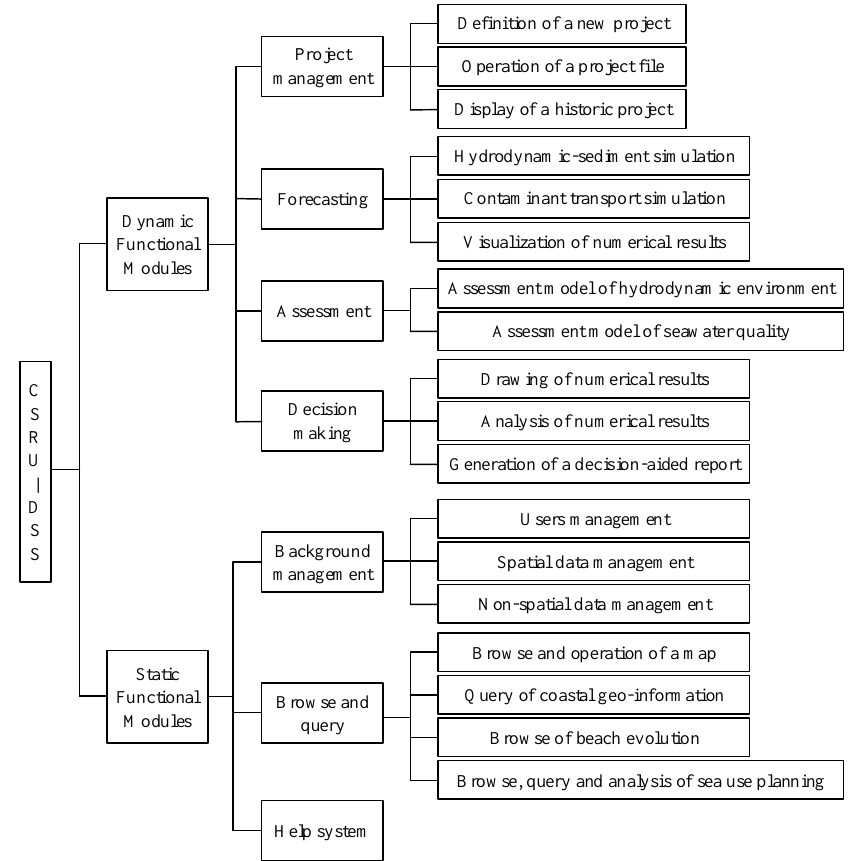
Figure 1. Functional modules of the CSRU-DSS.